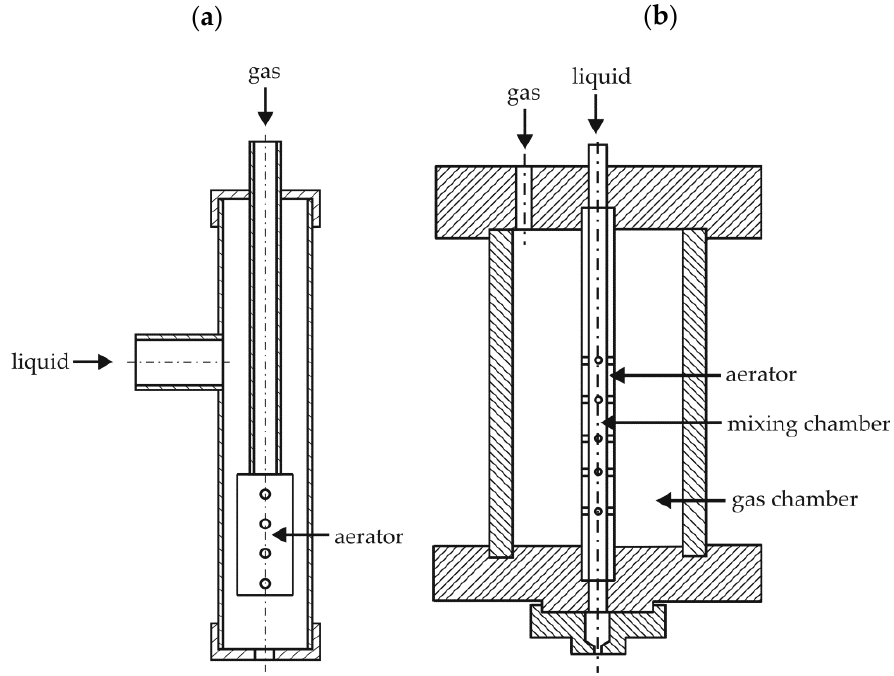
Figure 2. Exemplary schemes of effervescent atomizers of the type [20,44]: ( a ) inside-out, ( b ) out- side-in.